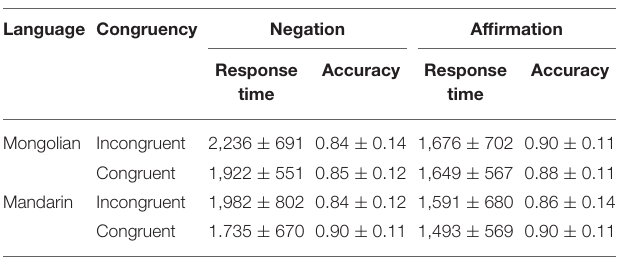
TABLE 3 | Means and standard deviations of response time (ms) and accuracy rate (%) at 750 ISI. Language